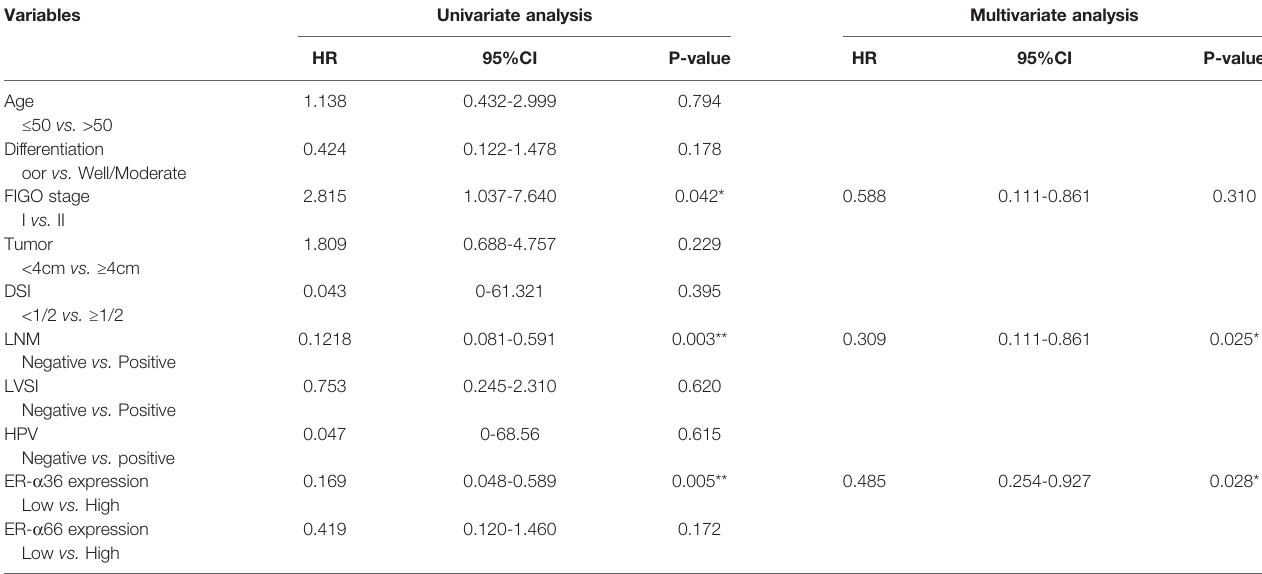
TABLE 3 | Univariate and multivariate analyses of overall survival in cervical SCC patients.